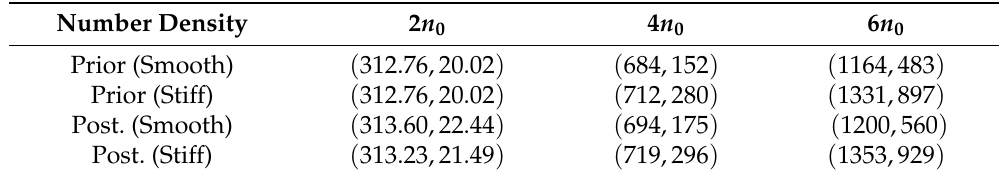
Table 1. Average values of energy density and pressure ( ε , p ) in units of MeVfm − 3 at each baryon number